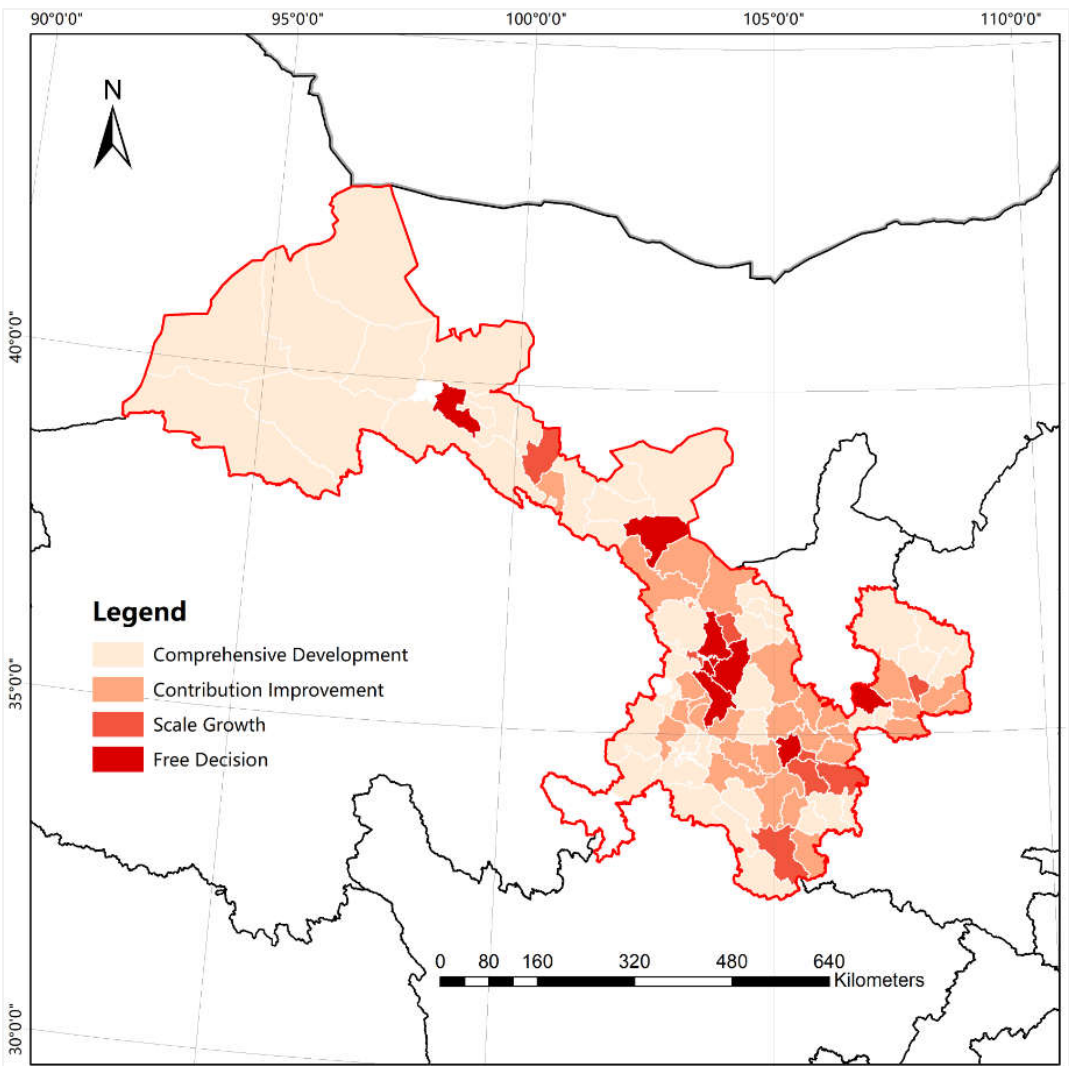
Figure 12. Policy classification chart of the real estate market development.